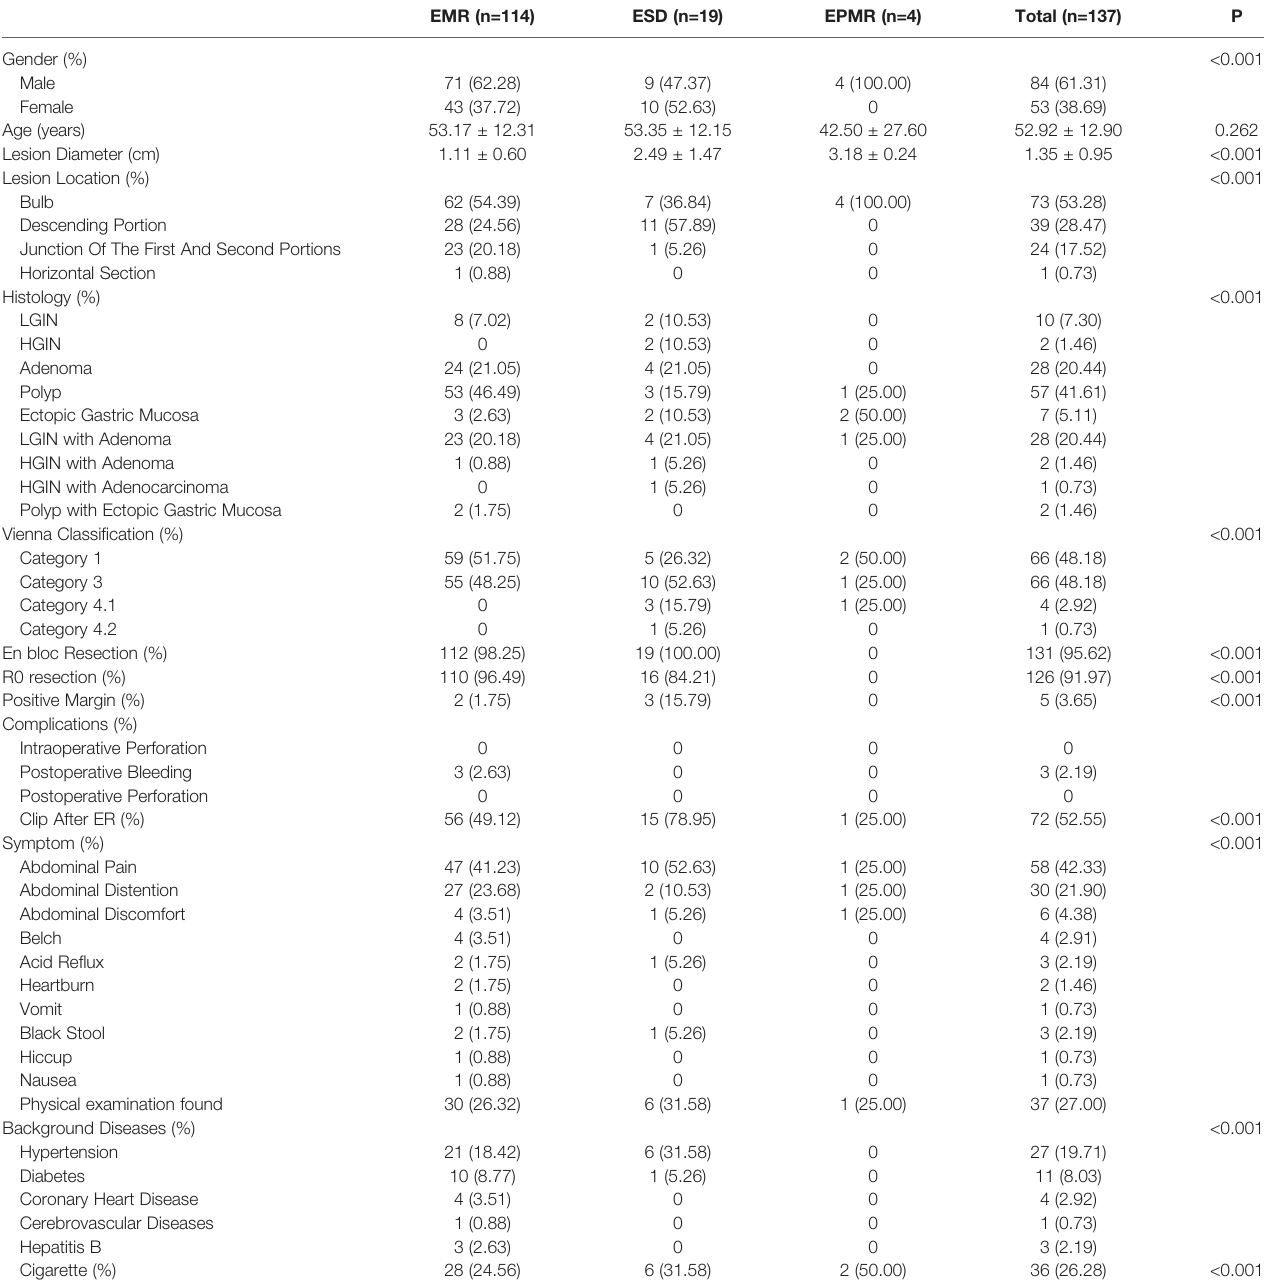
TABLE 1 | Characteristics of the 137 cases of SDELs treated with endoscopic resetion. EMR (n=114) P Gender (%) <0.001